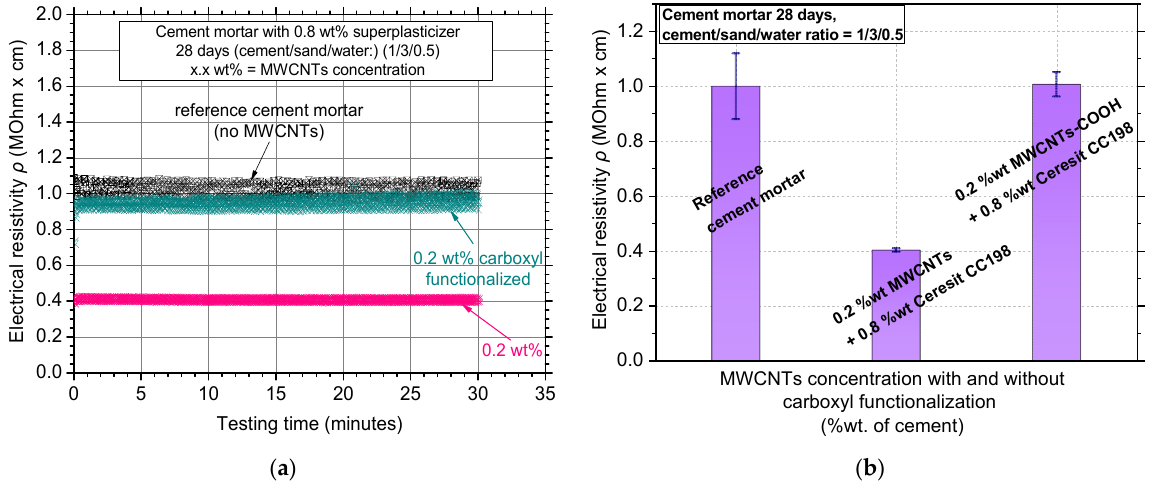
Figure 12. ( a ) Electrical resistivity curves over testing time and ( b ) average electrical resistivity values of MWCNT/white mortar nanocomposites where MWCNTs were treated with and without carboxyl functionalization.